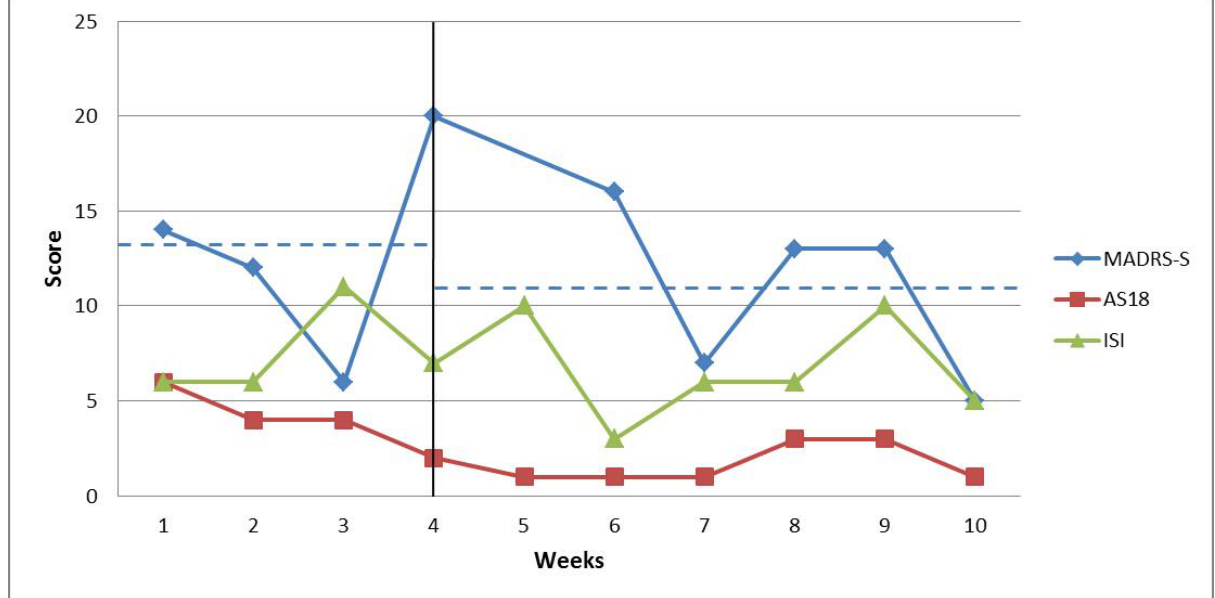
Figure 5. Weekly ratings of depressive symptoms (MADRS-S, maximum score is 54 points), symptoms of (hypo)mania (AS-18, maximum score for mania section is 36), and insomnia (ISI, maximum score is 28 points) for patient 4. The vertical line marks the start of the intervention period. Dashed blue lines indicate the mean level of depressive symptoms (MADRS-S) during the baseline period and the treatment